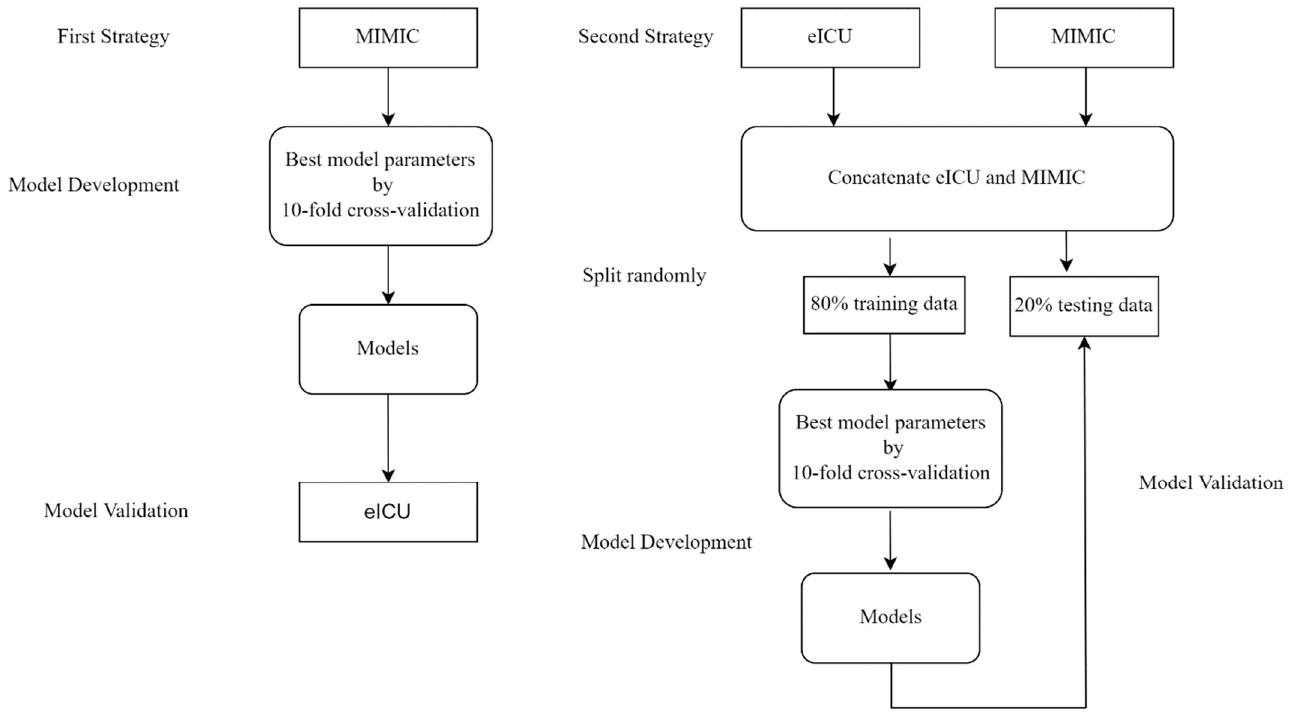
Figure 1. Model development and validation flowchart.